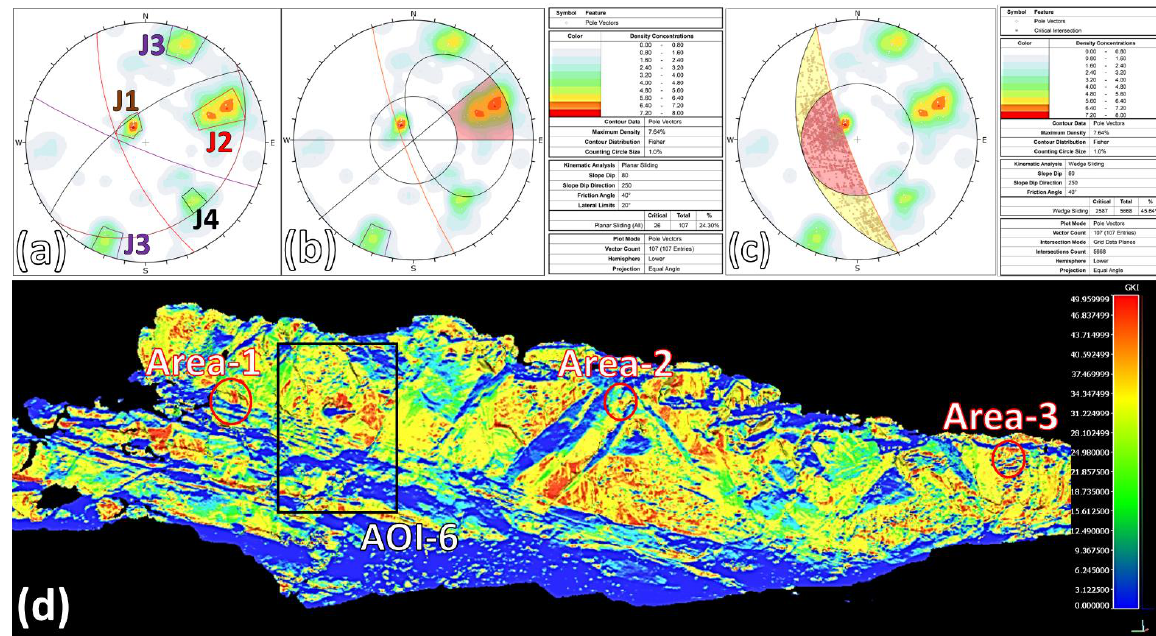
Figure 15. Structural data in the site of Uplistsikhe: main discontinuity sets ( a ); 2D kynematic analysis for planar ( b ) and wedge failures ( c ); 3D kynematic analysis (GKI index up to 49.9%) ( d ), showing the areas affected by rockfalls (Areas 1–2 in the red ovals), and the AOI highlighted in Figure 16 (black square).